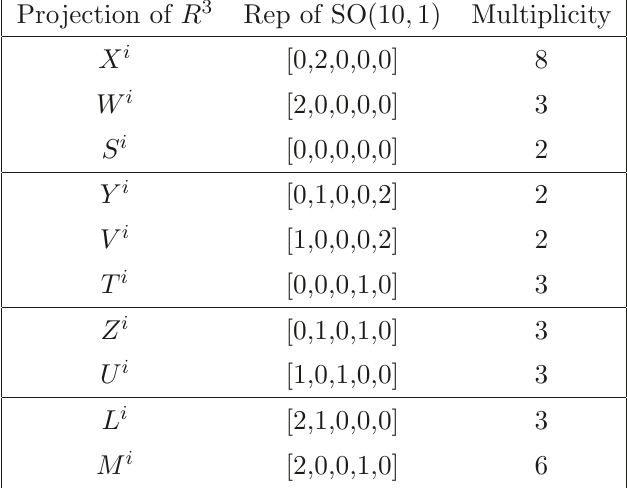
Table 2 . Valid embeddings of